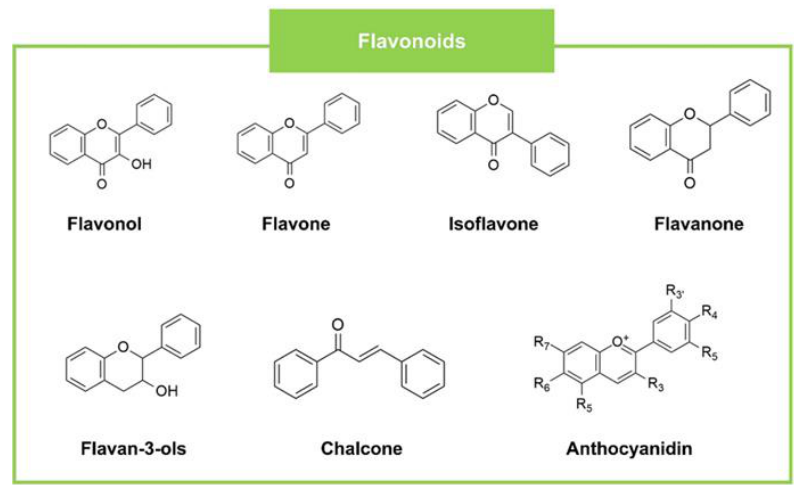
Figure 3. Representative chemical structures of different classes of